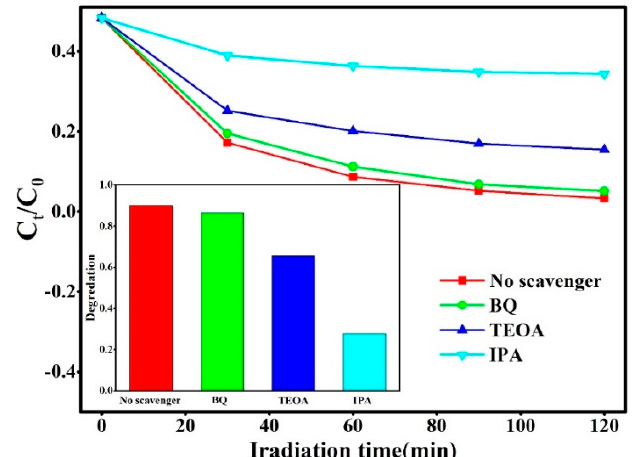
Figure 8. The photocatalytic cycle stability of 3% Ag 2 S@SnS 2 composite.